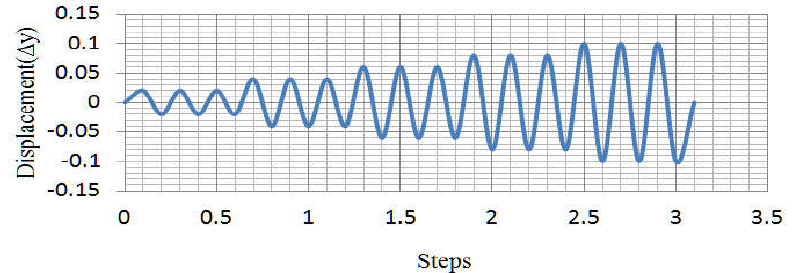
Figure 2. Loading protocol according to ATC24 [17,18].